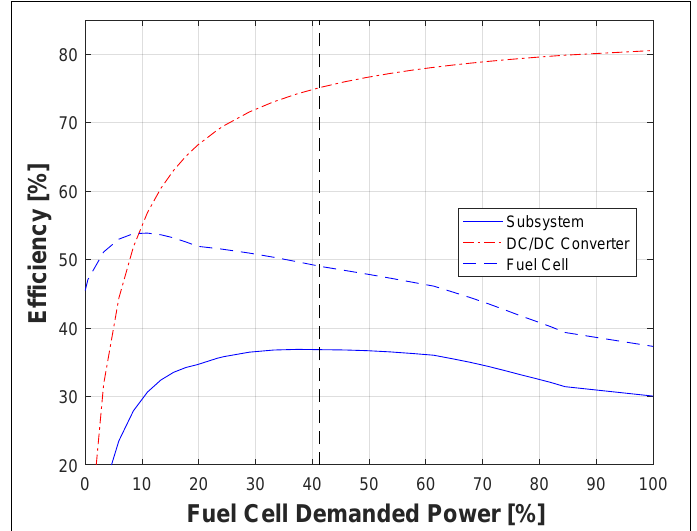
Figure 6. Fuel cell-DC/DC converter subsystem